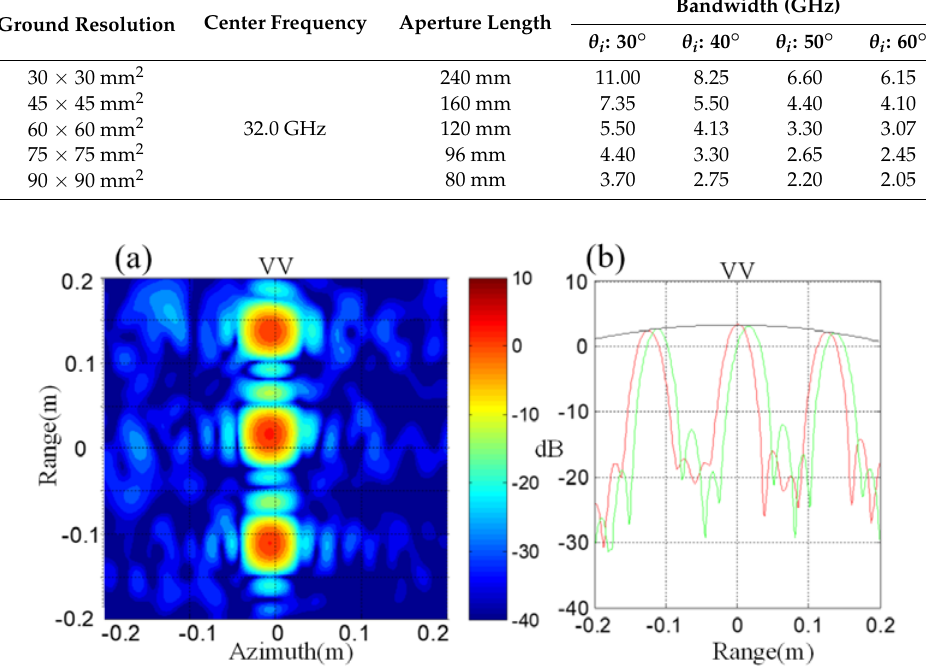
Figure 4. Image and range profiles of 3 small metal balls, showing the non ‐ uniform illumination due to the antenna pattern effect. ( a ): Image profile; ( b ): Range profile (Two cut lines were obtained by performing 180° rotation of φ in the measurements).